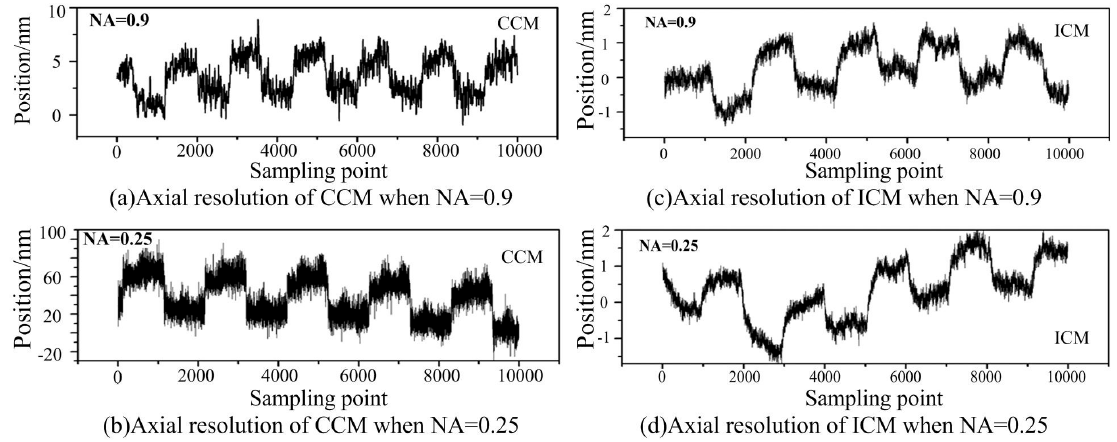
Figure 5. Comparison of the axial resolution between CCM and the ICM with different objective lenses.